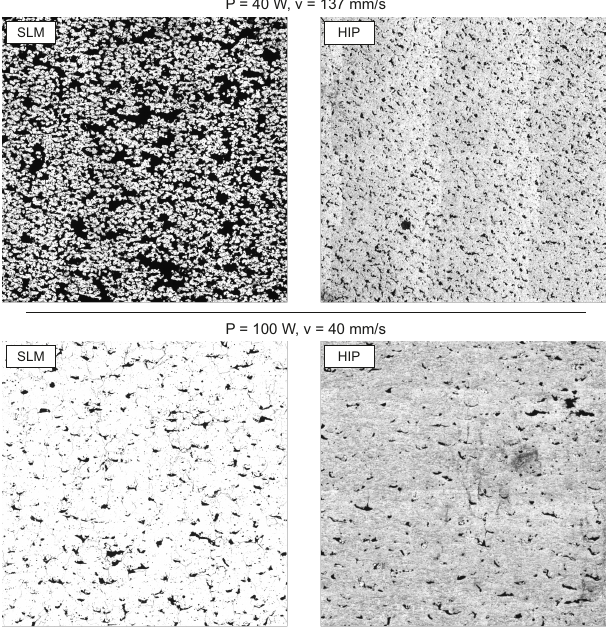
Figure 8. Macrographs showing the distribution of sizes and shapes of pores for low and high energy densities before and after the hot isostatic pressing (HIP)